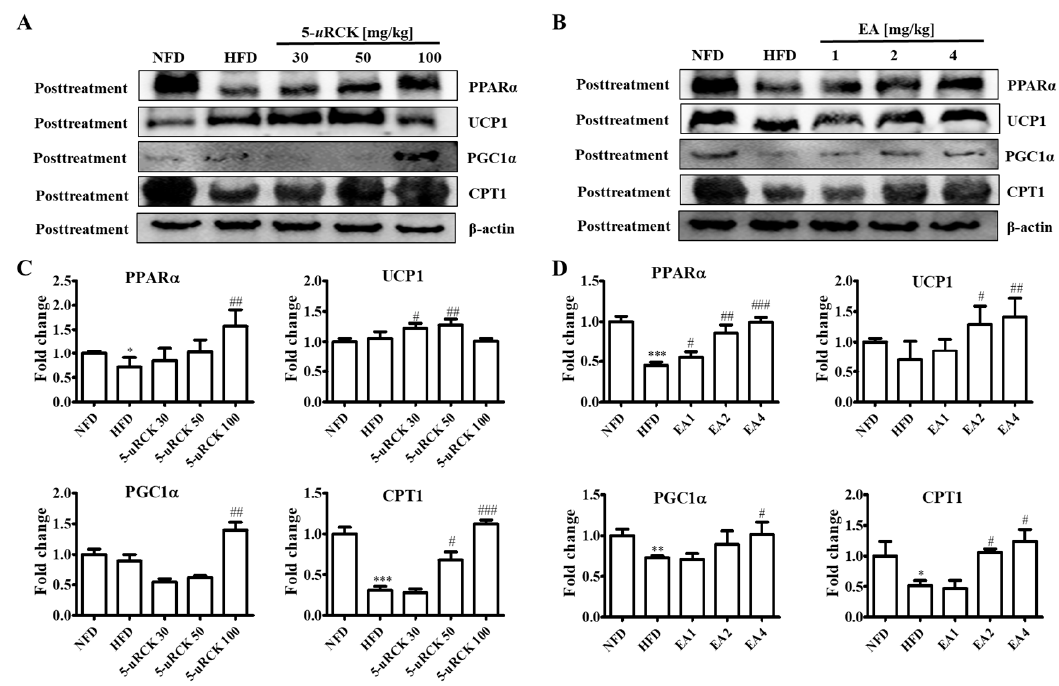
Figure 8. Effect of 5- u RCK and ellagic acid supplementation on fat browning-associated protein expression in HFD-fed mice inguinal white adipose tissue (ingWAT). Effects of 5-uRCK ( A ) and ellagic acid ( B ) on peroxisome proliferator-activated receptor α (PPAR α ), uncoupling protein 1 (UCP1), peroxisome proliferator-activated receptor- γ coactivator-1 α (PGC1 α ), and carnitine palmitoyl transferase-1 (CPT1) expression in the ingWAT and assessed by Western blot analysis. Each value ( C , D ) was normalized to β -actin and expressed as the mean ± SD. P values for comparisons with control groups (NFD groups) are denoted as * p < 0.05, ** p < 0.01 and *** p < 0.001, and those for comparisons with HFD groups are denoted as # p < 0.05, ## p < 0.01, and ### p < 0.001.